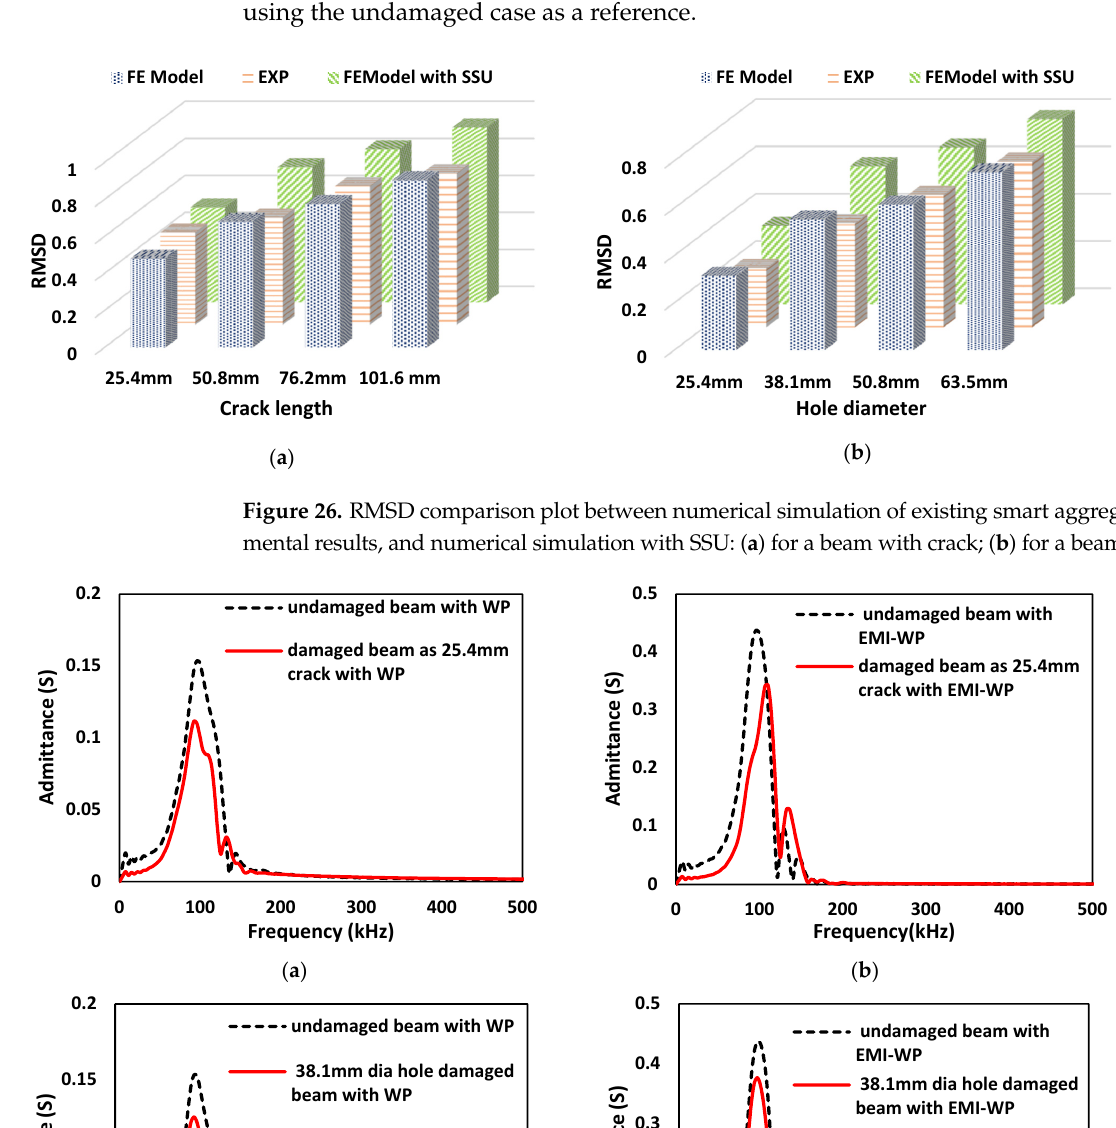
Figure 28. RMSD plot for a concrete beam under different structural conditions. The sensing capabilities of SSUs are improved when EMI-WP techniques are com- bined, and the RMSD value is increased, resulting in greater damage identification. As a